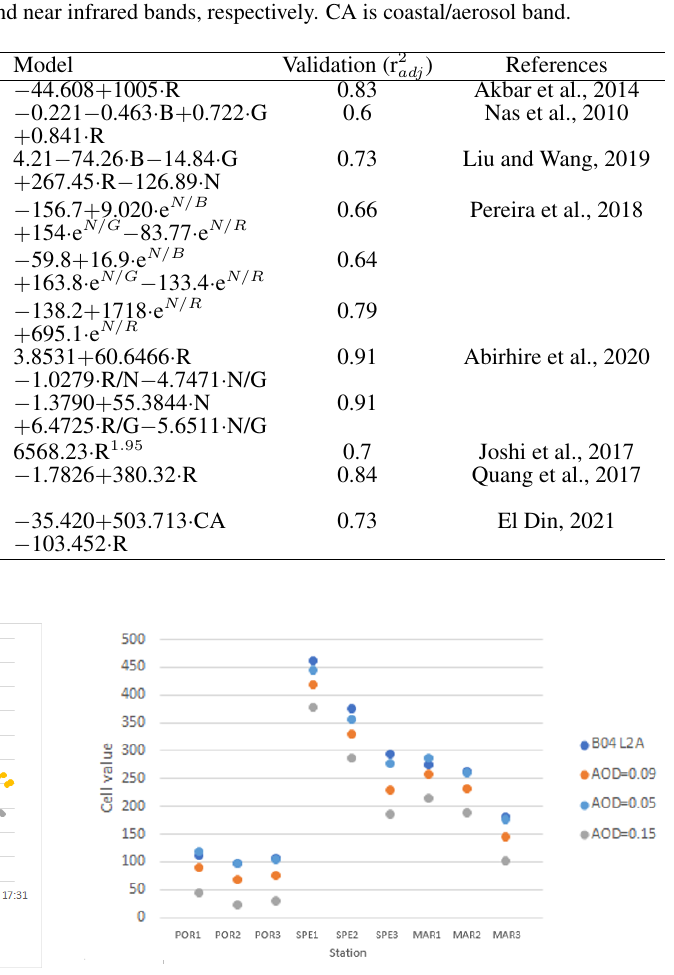
Figure 4. Comparison between L2A reflectance and L1C values Figure 3. Example of AOD variability during the day in the corrected using i.atcorr and different AOD values in different stations. corrispondence at in situ stations and for the red band.